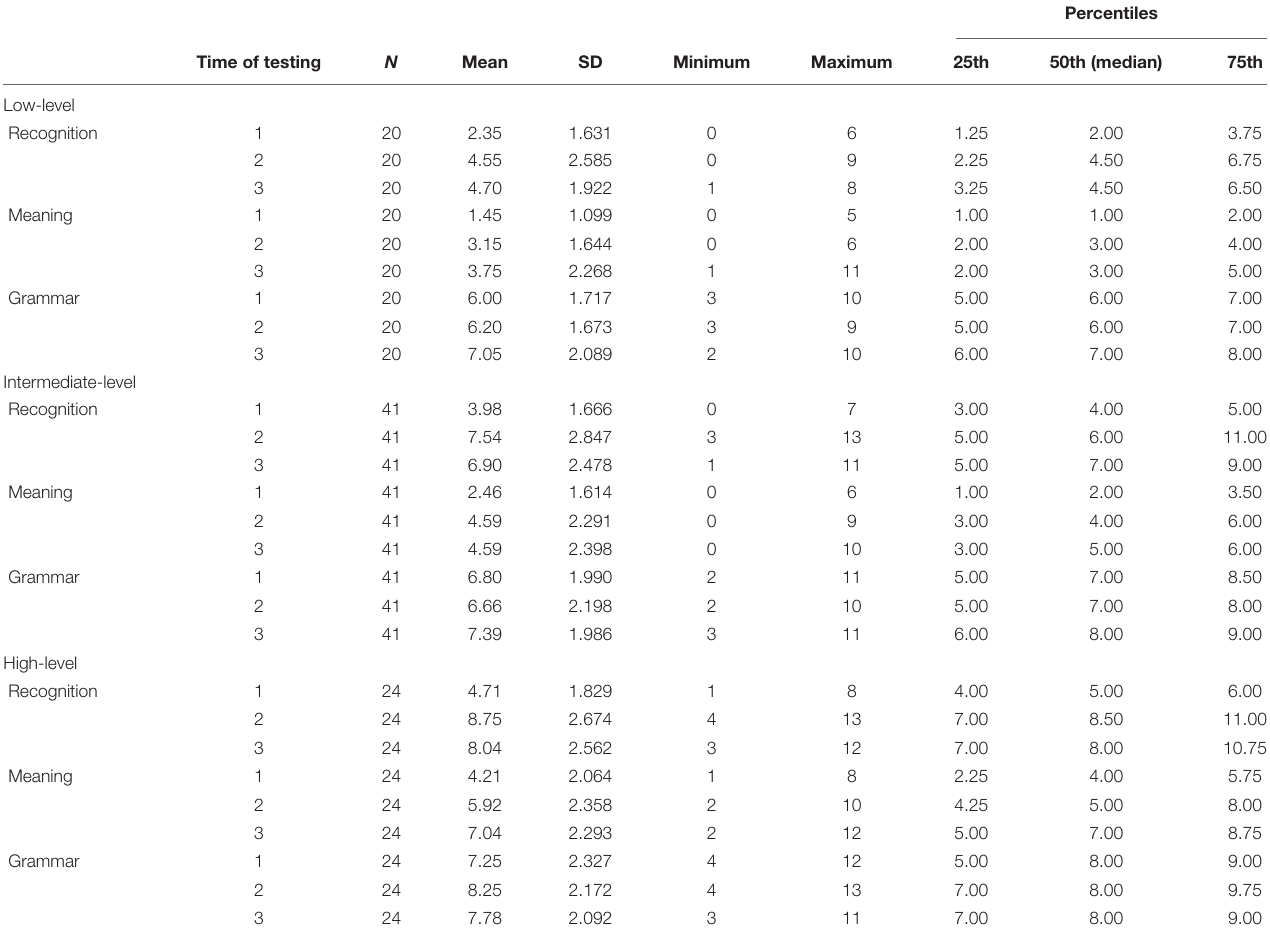
TABLE 6 | Descriptive statistics for prior vocabulary